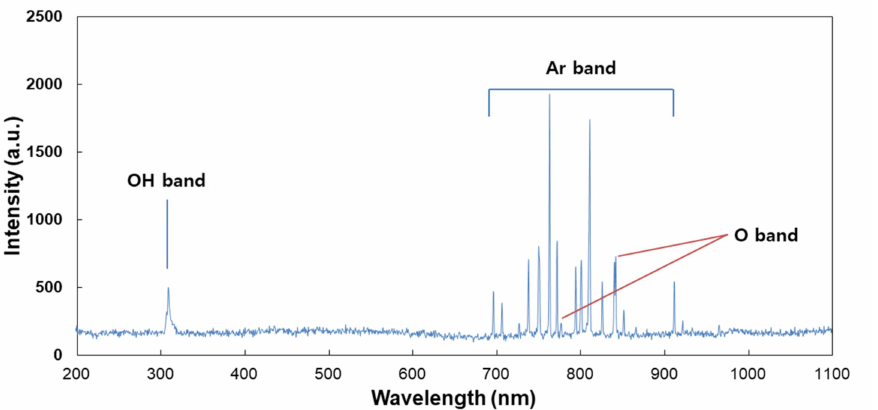
Figure 2. Optical emission spectrum (OES) measurement of the CAP plume. An optical fiber was measured from the position of 3 mm along the axial direction of the CAP plume.